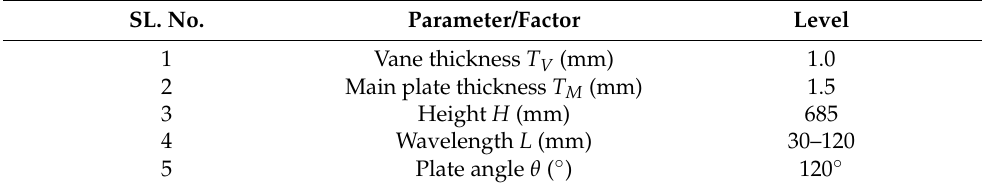
Table 2. The basic geometric parameters of curved vane demisters. SL.